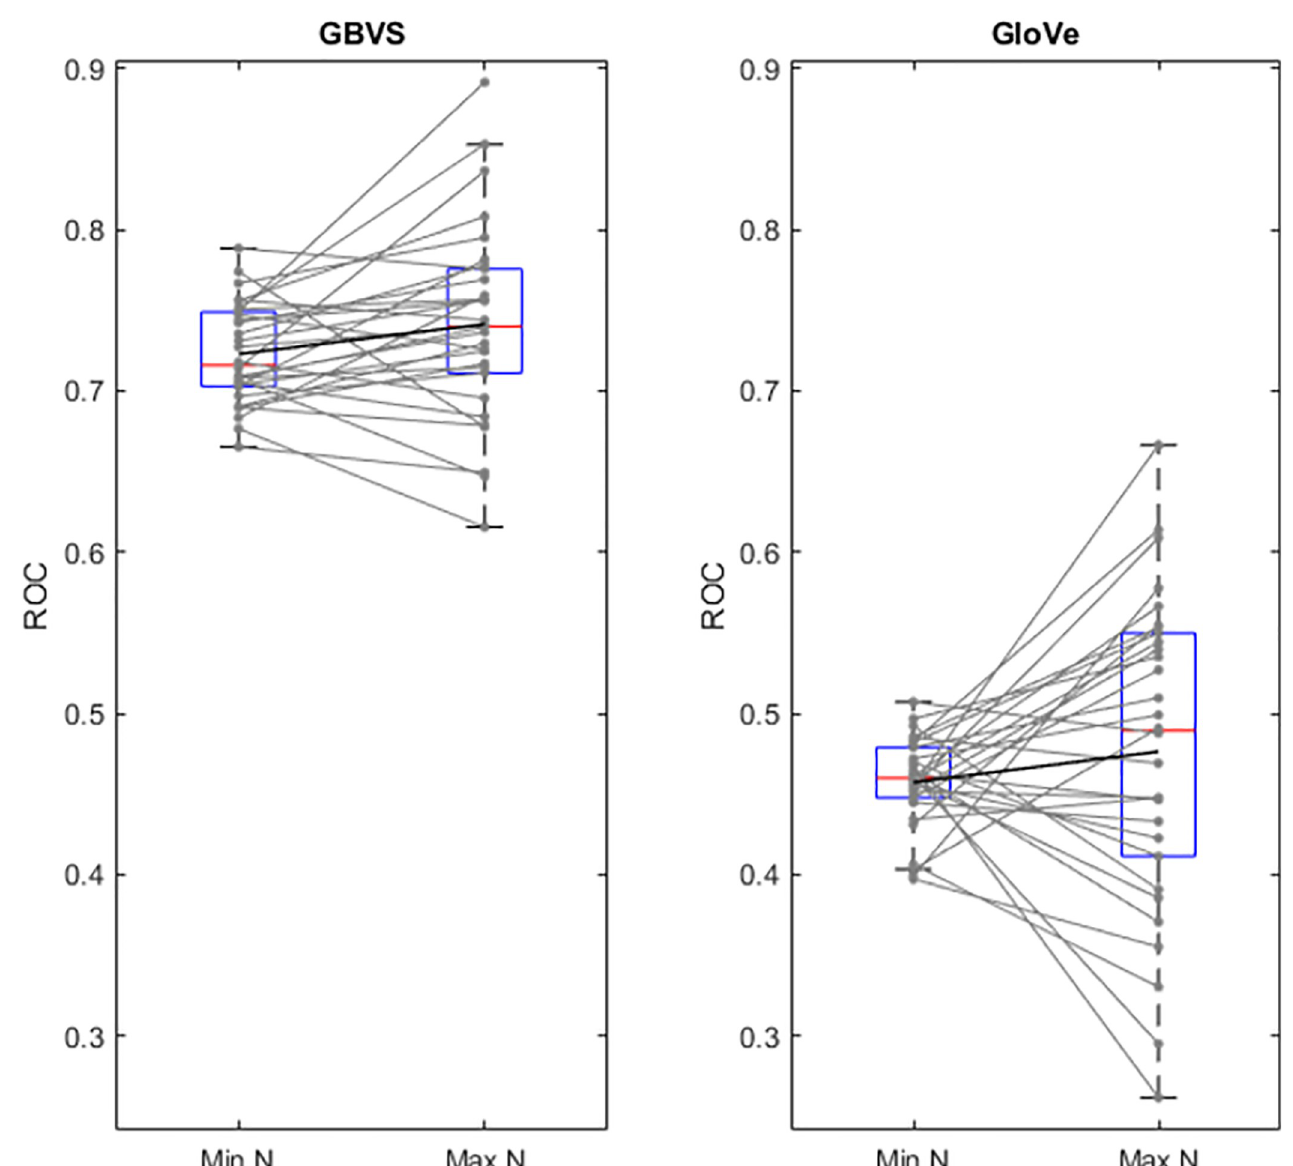
Fig 7. Area under the ROC at minimum and maximum cognitive load for each model. Grey lines represent individual traces. Black line represents mean values. Minimum N (minimum load) for all subjects was N = 0, maximum N (maximum load) was variable across subjects. Red lines show median, boxes show interquartile range and whiskers show 95% confidence